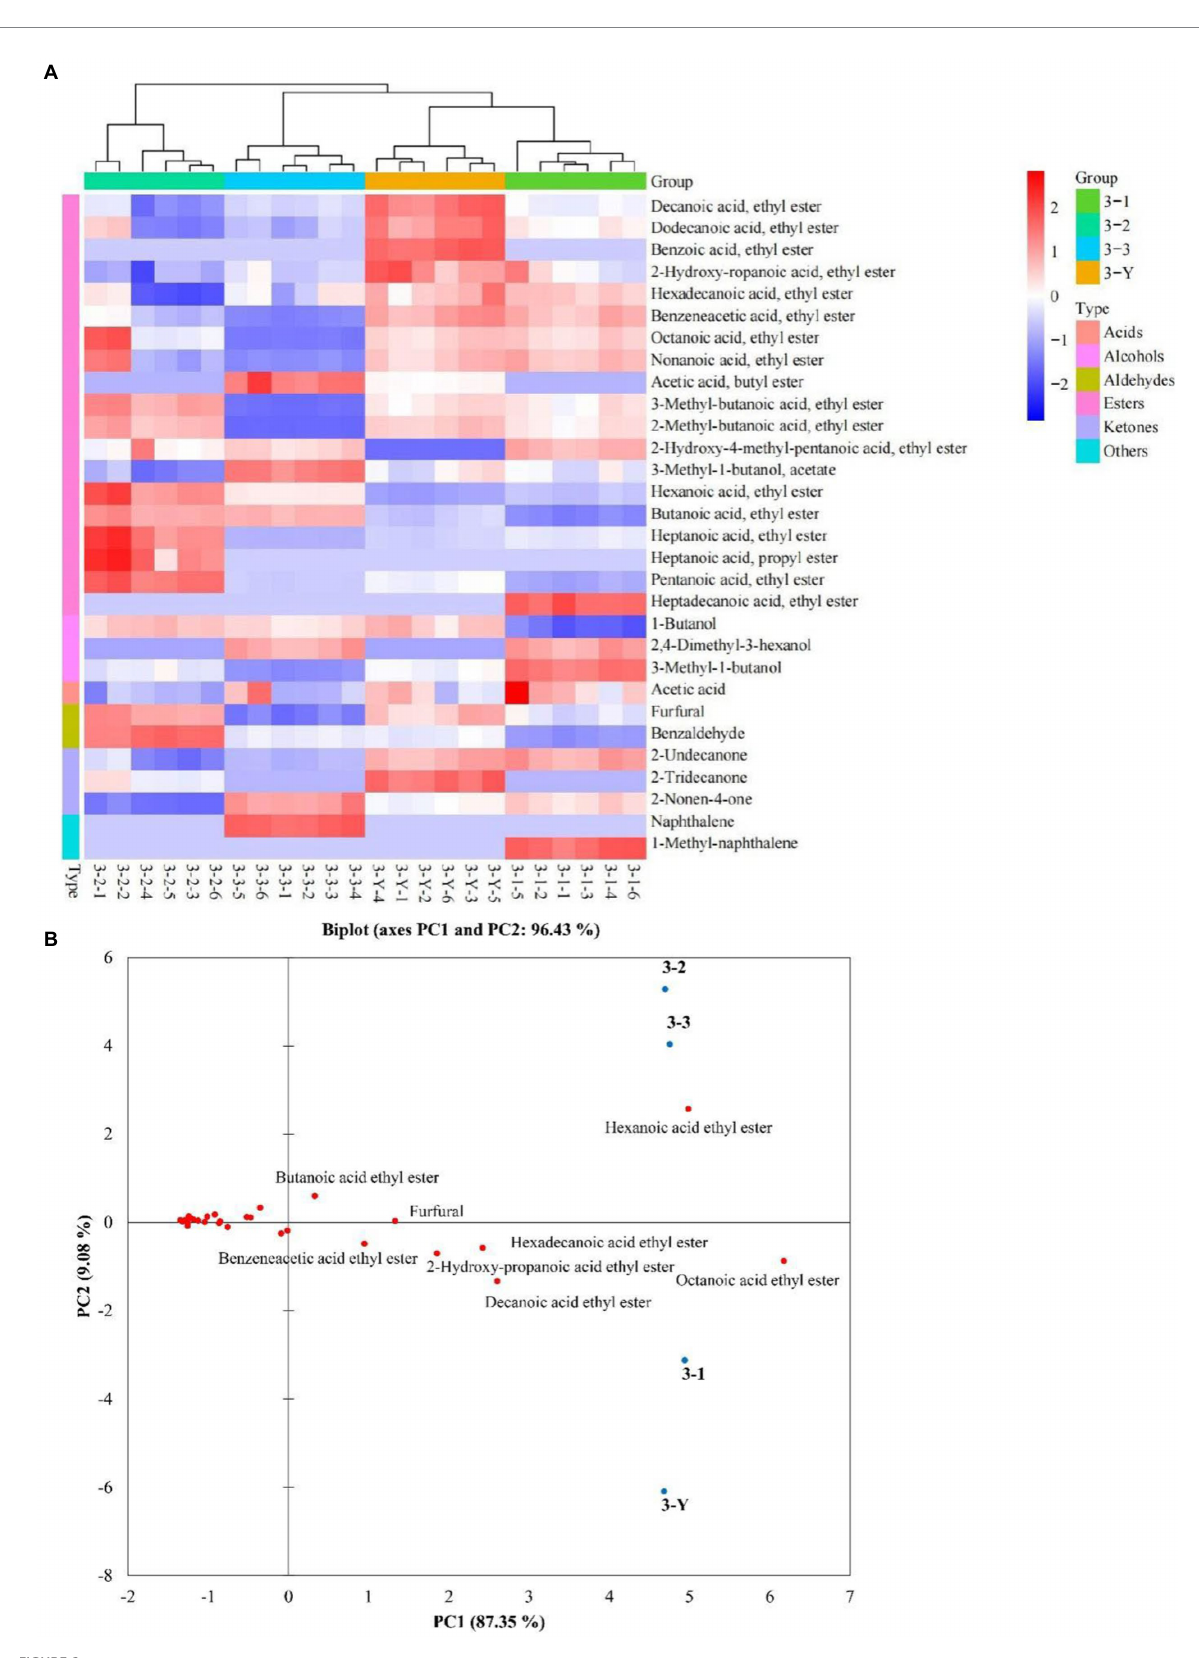
FIGURE 6 Heatmap (A) and principal component analysis (PCA) biplot (B) of differential compounds in different quality grades of base liquor of 3rd round of